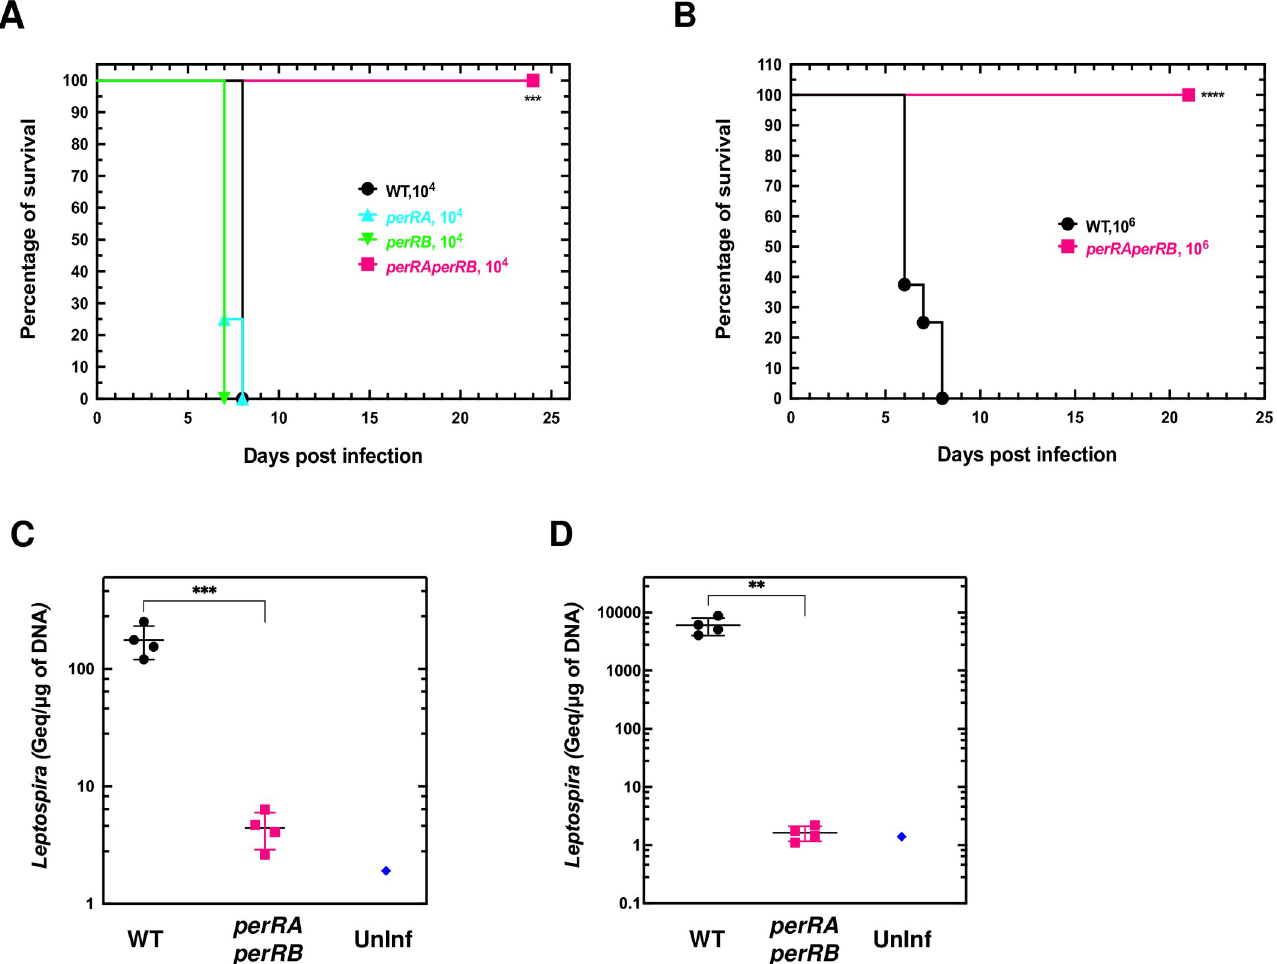
Fig 7. Effect of concomitant inactivation of perRA and perRB on Leptospira virulence. Virulence (A) was assessed by infecting hamsters (n = 4–8) by peritoneal route with 10 4 (A) or 10 6 (B) WT (black circles), 10 4 single perRA or perRB mutants (cyan triangles and green inverted triangles, respectively), or 10 4 (A) or 10 6 (B) double perRAperRB mutant (pink squares) strains as described in Materials and Methods section. Leptospiral load in kidney (C) and liver (D) of hamsters (n = 4) infected with the WT (black circles) or with the perRAperRB mutant (pink squares) was assessed by quantitative PCR as described in the Materials and Methods section. A sample of non-infected hamsters (blue diamonds) was included as a control. Statistical significance in comparison with WT samples was determined by a Log rank Mantel Cox test (in A, ��� p-value = 0.0009; in B, ���� p-value < 0.0001) and by an unpaired t- test (in C, ��� p- value = 0.0009; in D, �� p-value =